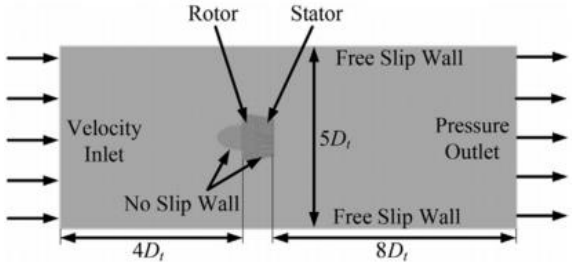
Figure 10. Computational domain of pump-jet.